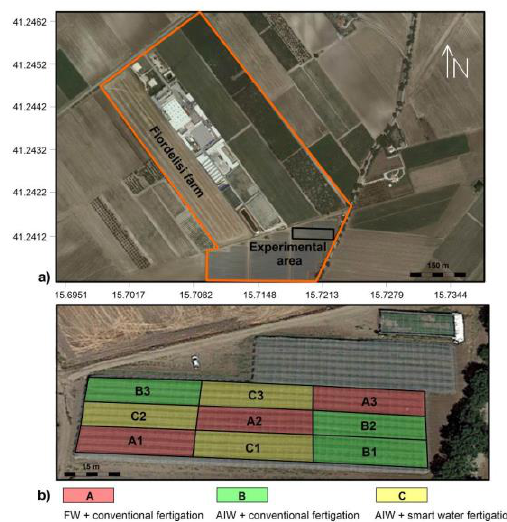
Figure 1. Satellite map of the study area (Google Earth image): ( a ) experimental field belonging to the Fiordelisi farm; ( b ) details of the experimental area with irrigation setup.